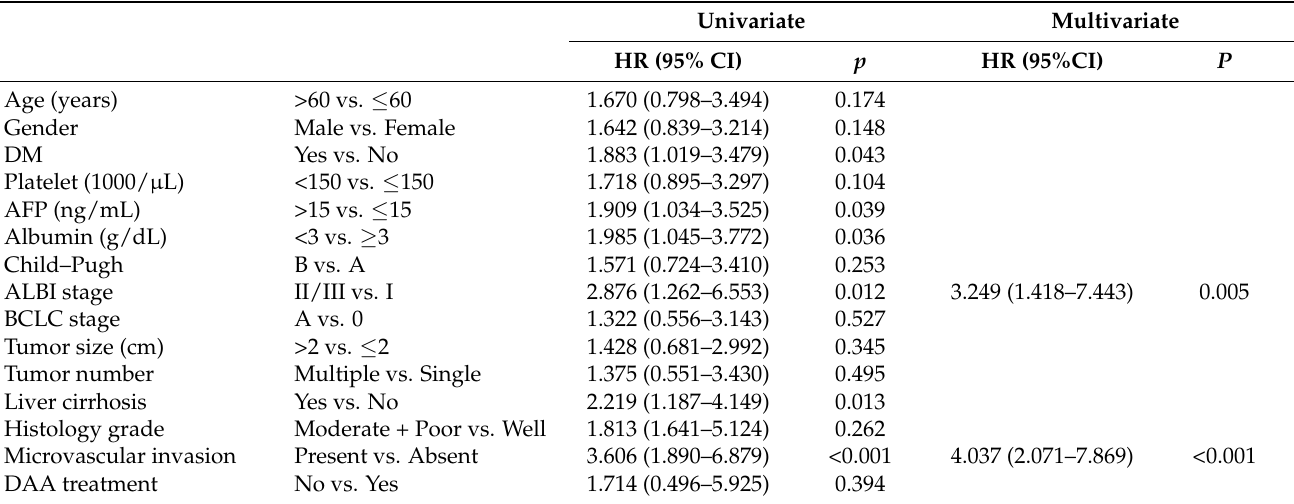
Table 3. Uni- and multivariate analyses of prognostic factors for all-cause mortality.